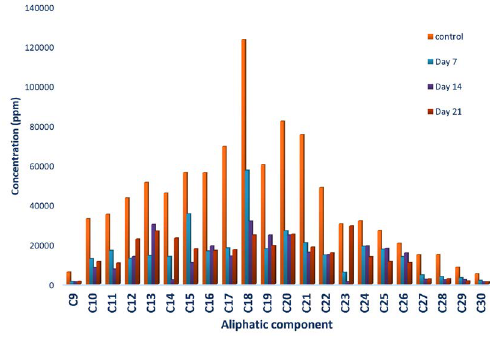
Fig. 7. Interpretation of gas chromatographic of n-hexane extract of residual crude oil from Bacteria Consortium ( Bacillus cereus , Dyadobacter koreensis and Pseudomonas aeruginosa, Campylobacter hominis and Micrococcus luteus) culture